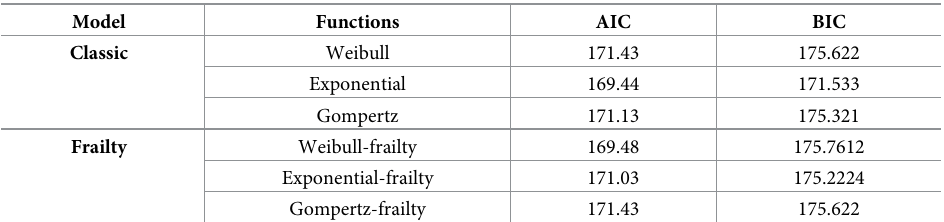
Table 1. The GOF values of classical and frailty models for the excavator failure